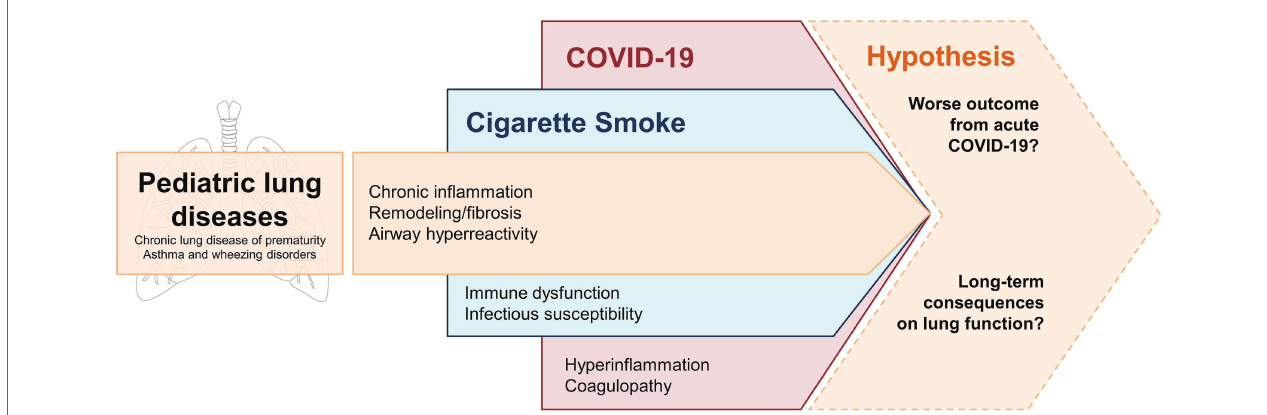
FIGURE 2 | Potential “multiple hits” effect of CSE and COVID-19 on developing lungs affected by common pediatric lung diseases – i.e., chronic lung disease of prematurity, asthma, and wheezing disorders. Underlying processes of inflammation and tissue remodeling are enhanced by chronic CSE. SARS-CoV-2 infection triggers an acute inflammatory response that may compromise the respiratory function of these vulnerable patients. Longitudinal clinical data are needed to confirm whether these factors have an additive effect that leads to more severe COVID-19 manifestations and/or long-term consequences in terms of lung function